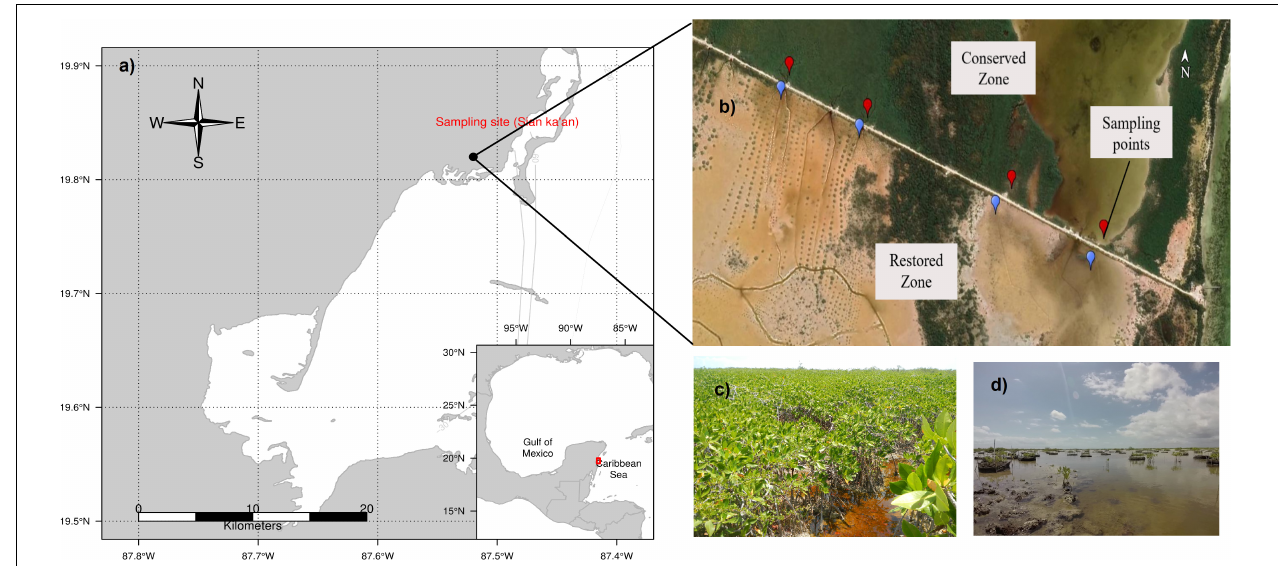
FIGURE 1 | (a) Location of the El Playon mangrove ecosystem, Sian Ka’an, Quintana Roo, Mexico. (b) Sample sites in conserved area of R. mangle and restored area with channels and reforestation of R. mangle . (c) Photography of conserved site of R. mangle and (d) restored zone of mangrove.